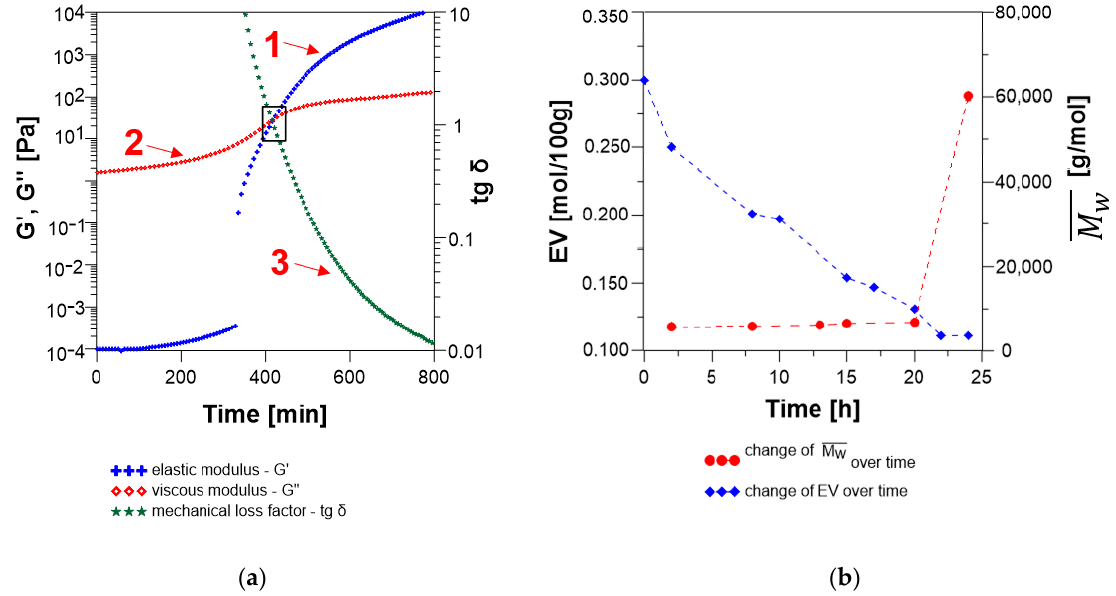
Figure 9. ( a ) Changes in the storage modulus (curve 1), loss modulus (curve 2) and the loss tangent tg δ (curve 3) over time for the polyaddition process of hydroxyl soybean oil with low-molecular-weight epoxy resin EPR0162; ( b ) changes in oxirane group content (EV) and molecular weight during the process SMEG_EPR.